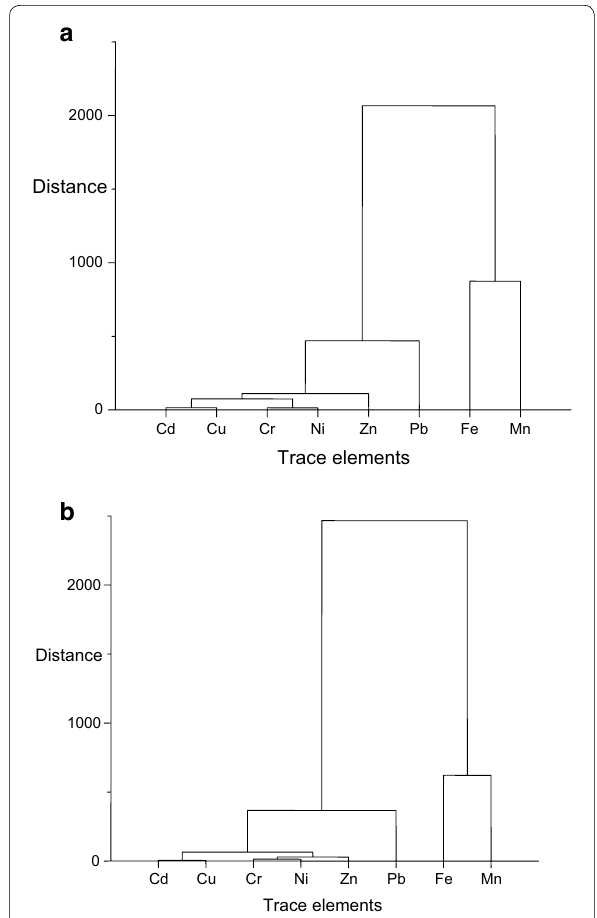
Fig. 4 Cluster analyses of 8 trace elements. a Dry season; b in the rainy season